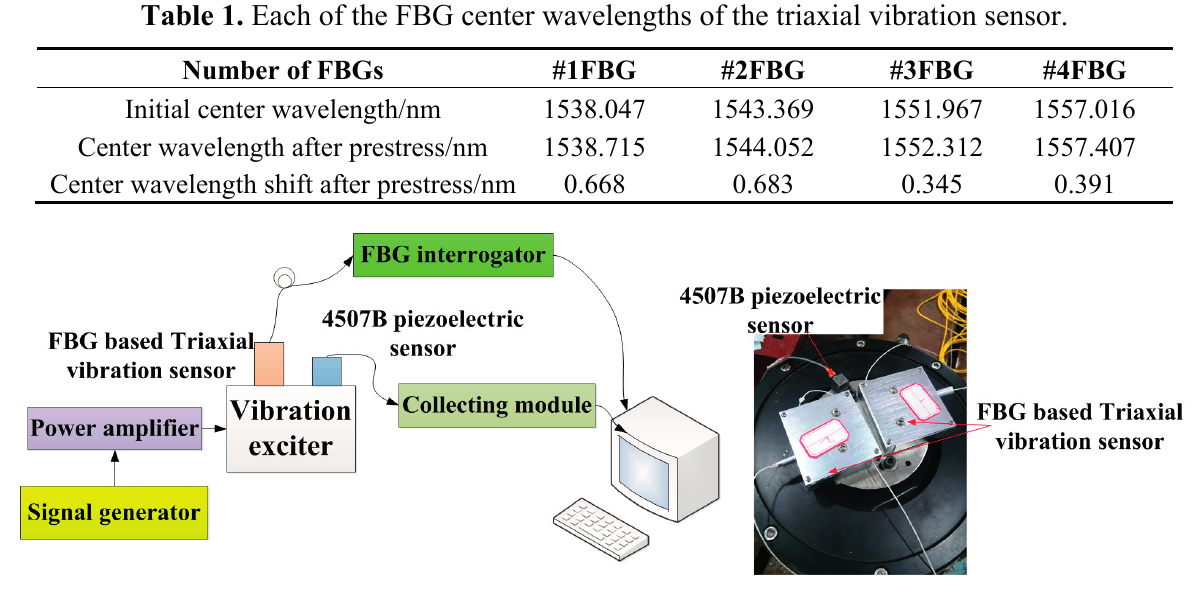
Figure 4. Schematic diagram and photograph of sensing characteristics